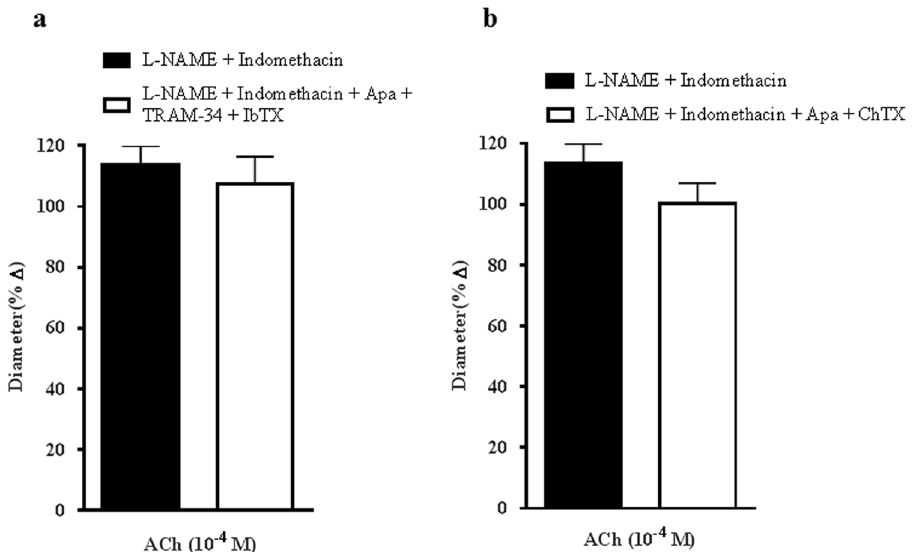
Figure 6. Calcium-activated potassium ion (K Ca ) channels are not involved in mediating endothelium- dependent vasodilatory responses. ( a ) The combination blocking of the K Ca channels with their respective specific blockers, Apa, TRAM-34 and IbTX and, ( b ) combined blockade with Apa and ChTX conferred negligible inhibitory effects on ACh-induced vasodilation. Values are expressed as mean ± s.e.m (n = 6 per